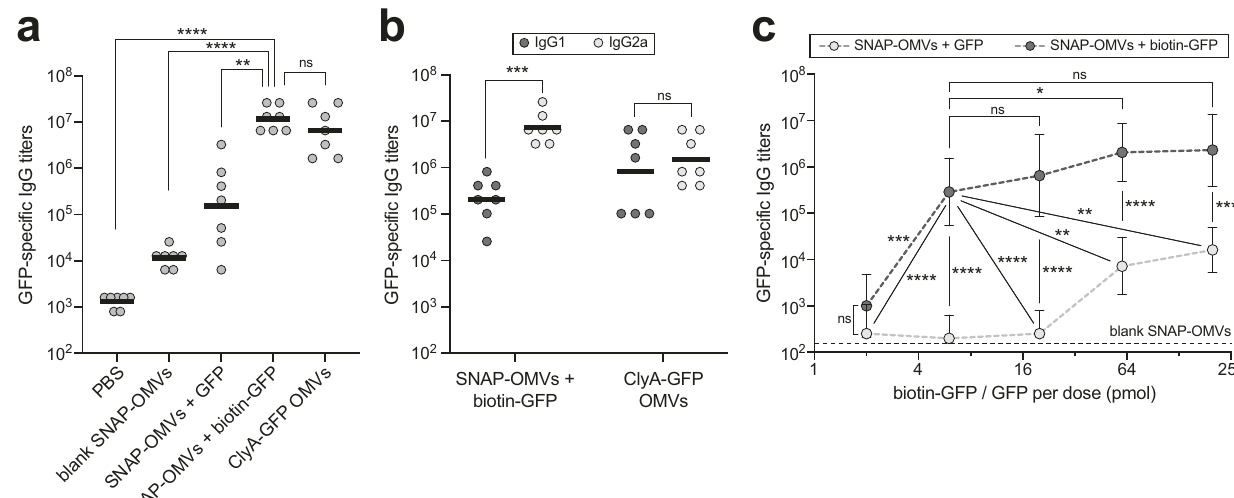
Fig. 4 | SNAP-OMVs decorated with biotin-GFP boost GFP-speci fi c IgG titers. a MeanGFP-speci fi cIgGtiters(horizontalblacklines)inendpoint(day56)serumof individual mice in each group (gray circles). Five groups of six-week-old BALB/c mice (seven mice per group) were immunized s.c. with the following: PBS, blank SNAP-OMVs, SNAP-OMVs mixed with 20 pmol unbiotinylated or biotinylated GFP, and ClyA-GFP OMVs displaying a ClyA-GFP fusion. All OMVs were isolated from KPM404 Δ nlpI cells with the appropriate expression plasmid. Mice received prime injectionscontaininganequivalentamountofOMVs(20 μ gtotalprotein)onday0 and wereboosted on day 21and 42with the same doses. b Mean GFP-speci fi c IgG1 and IgG2a titers in the same endpoint serum of individual mice in select groups from ( a ). c Mean GFP-speci fi c IgG titers in mice receiving SNAP-OMVs formulated withescalatingdoses(2 – 200pmol)ofbiotinylatedGFP(physicallyassociated,dark